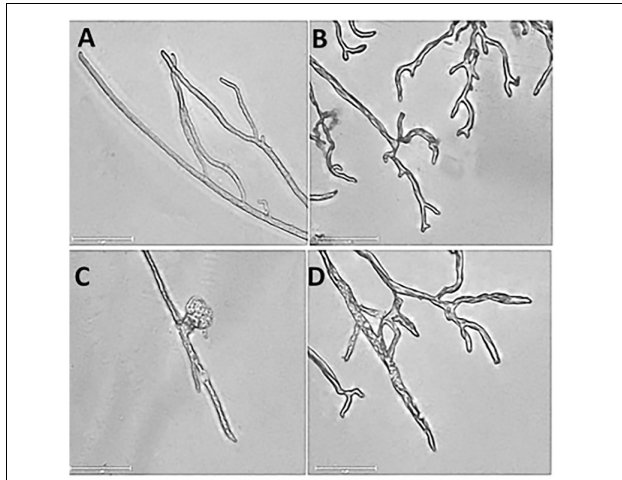
FIGURE 3 | The mycelial morphology of Botryosphaeria dothidea . (A) The mycelia of the untreated control. (B–D) The mycelia treated with 500 µ L/L dimethyl trisulfide for 24